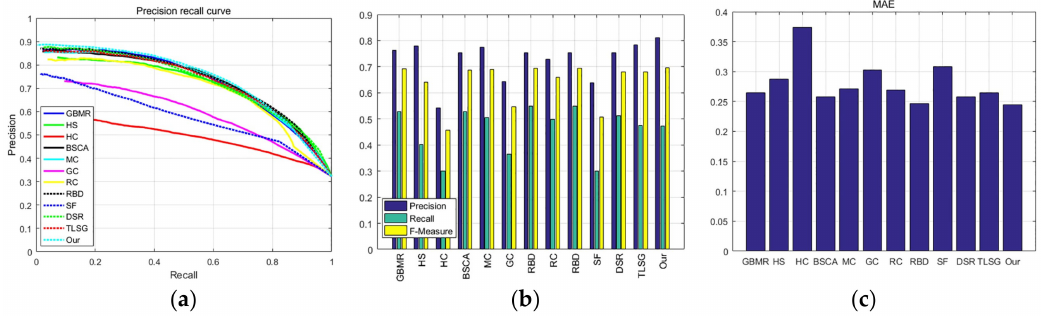
Figure 16. The comparison results on the DUT-OMRON dataset. ( a ) Precision-recall curves. ( b ) Precision, recall, and F-measure at adaptive threshold. ( c )